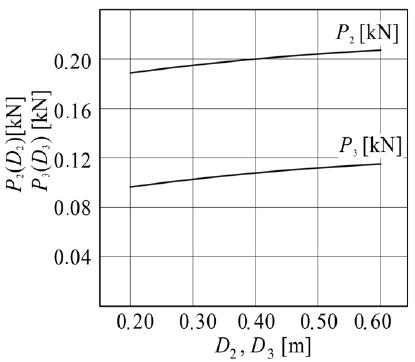
Figure 4. The dependence of the tractive resistance of the balancing and press wheels on their diameters Taking into account the calculated values of the tractive resistance and the calculations of the minimum allowable diameters using the ratio (7), the values of the diameters D and D should be selected from the range 2 3 of 0.30...0.40